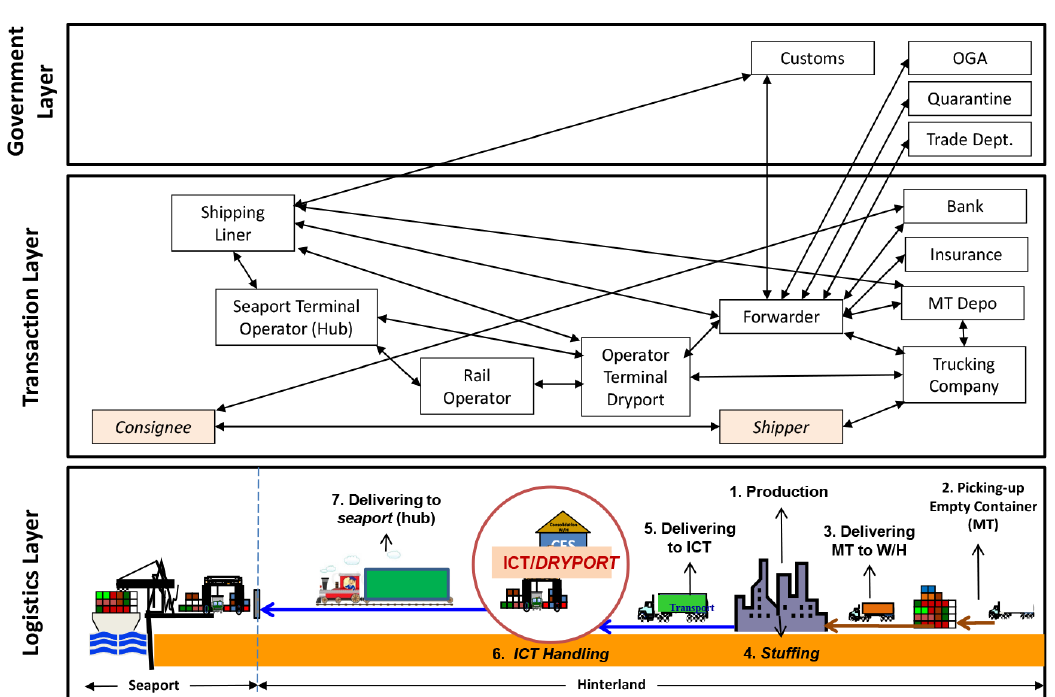
Figure 2. The Chain of Hub-and-Spoke Maritime Logistics